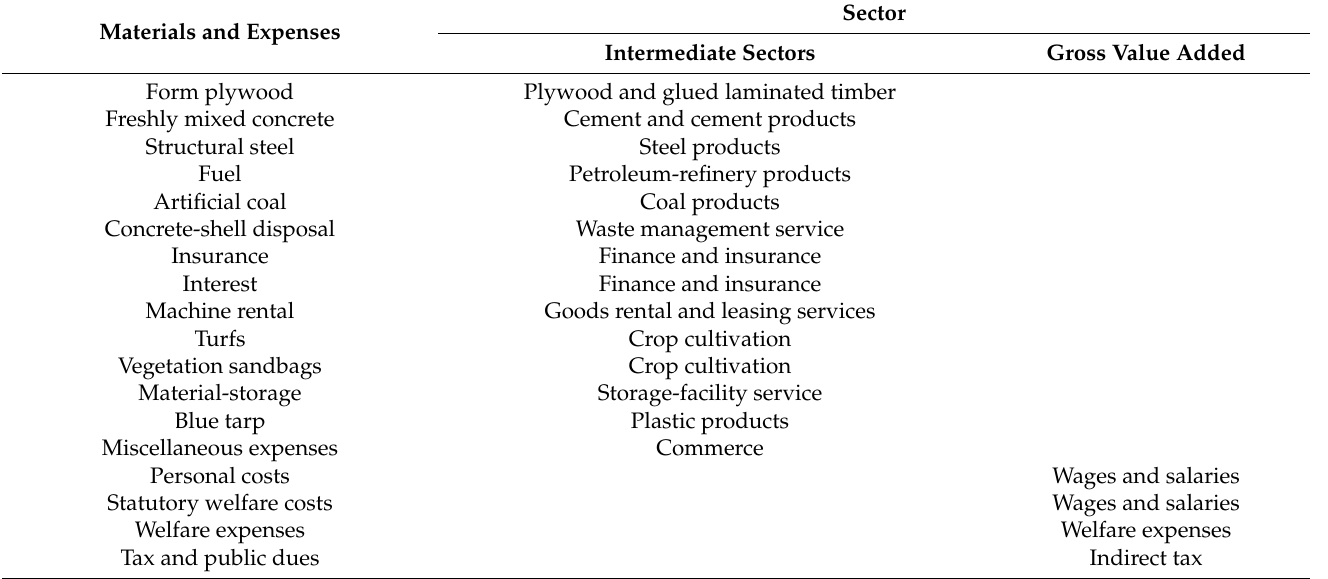
Table 2. Concrete dam: The materials and expenses and the corresponding industrial sectors